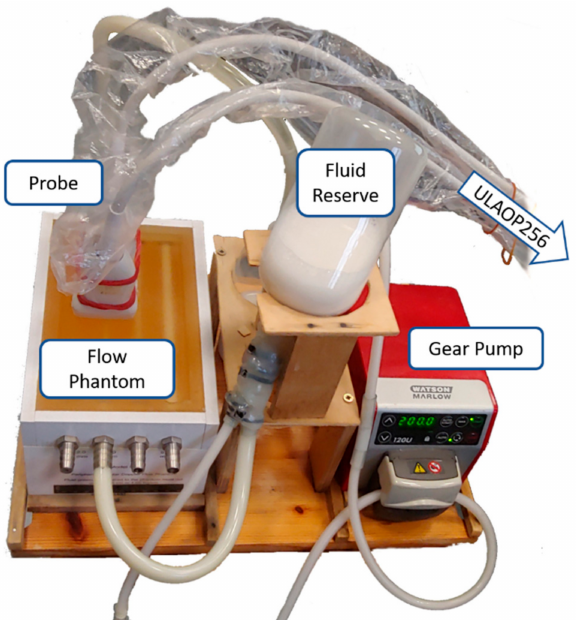
Figure 3. Experimental set-up. A gear pump (right) moved the blood mimicking fluid through a channel (4 or 6 mm diameter) in a wall-less phantom (left). The probe, connected to ULA-OP 256 scanner, was placed transversally on top of the